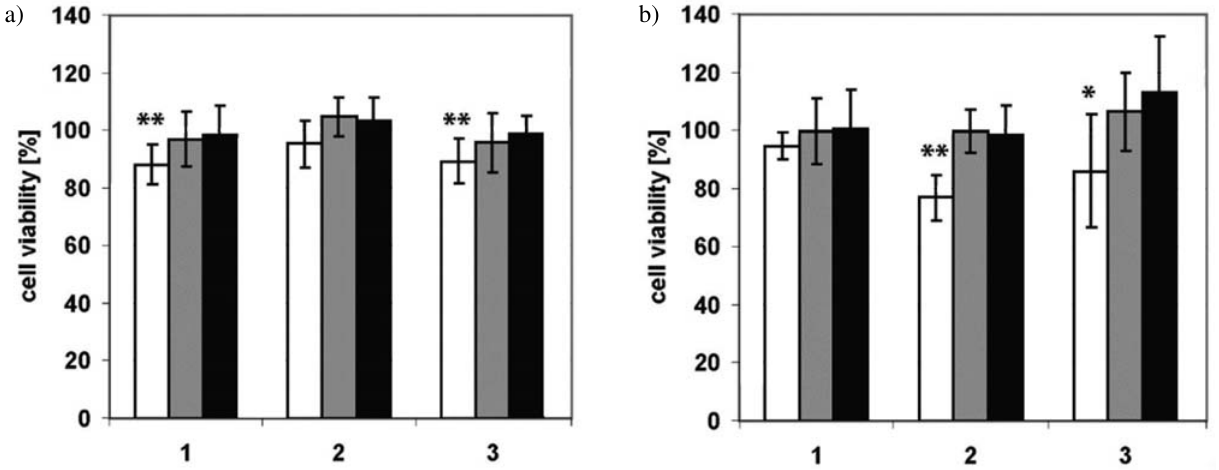
Figure 4. Influence of compounds 1 – 3 on the viability of ( A ) HeLa and ( B ) RAW264.7 cells after 24 h incubation. Substances were tested at 1 μM (dark grey bars), 10 μM (light grey bars) and 100 μM (white bars). Data is presented as mean percentage ±SD in comparison to control cells. n = 9 from three independent experiments.